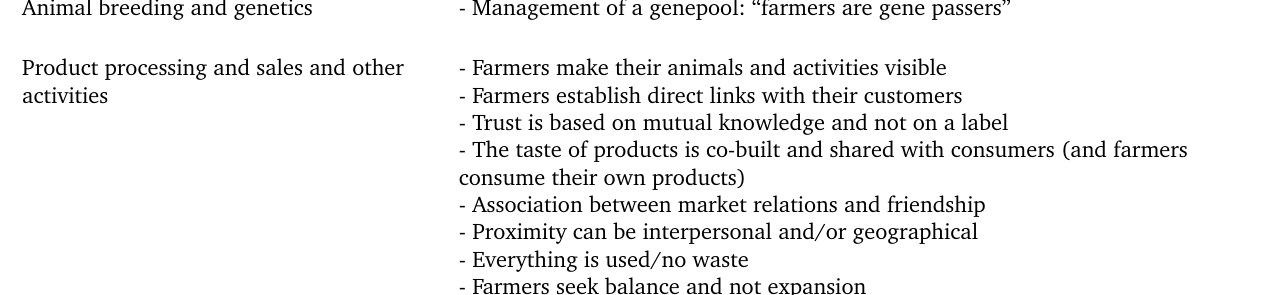
Table 1. What the participant farmers considered they had in common in their farming systems Dimensions of farming systems What farmers considered they had in common Livestock feeding systems and land use - Grazing-based systems - Free-range (quasi integral) - Orientation toward autonomy (principle to be modulated depending on the species) - Use of hedges - Purchased feed is not industrially processed - Floristic diversity - Match between the choice of environment and the choice of breed - Attention to animal health and animal wellbeing Animal breeding and genetics - Management of a genepool: “farmers are gene passers” Product processing and sales and other